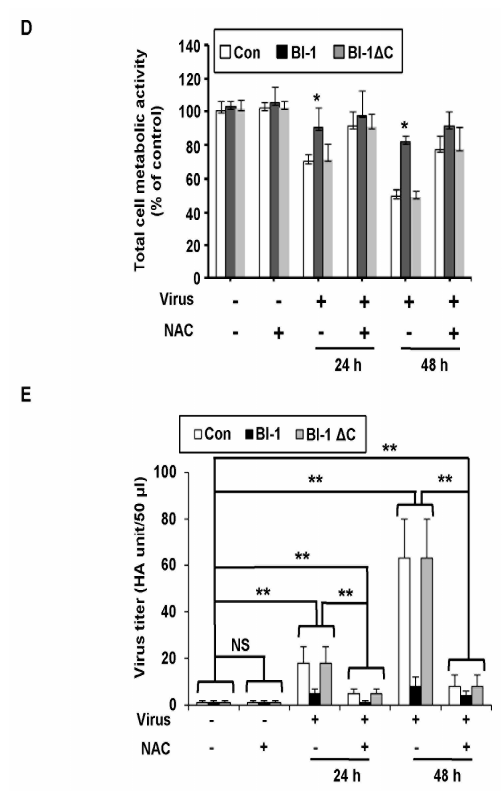
Figure 5. BI-1 may act as an antiviral protein through the suppression of ROS production and ROS-independent regulation of HO-1 expression. ( A ) Control mock MDCK, BI-1 -overexpressing MDCK, or BI-1 ∆ C-overexpressing cells were infected with A/PR/8/34 virus at 1000 TCID 50 and treated with NAC as an antioxidant agent. Intracellular ROS levels were measured in control mock MDCK, BI-1 -overexpressing MDCK, and BI-1 ∆ C-overexpressing MDCK cells incubated with Redox Red sensor CC-1. Fluorescence-stained cells were imaged on an inverted fluorescence microscope. (Scale bar- 200 µ m). ( B ) Relative expression of ROS was analyzed thrice by flow cytometer in indicated virus-infected cells with or without NAC treatment (** p < 0.01). ( C ) RT-PCR analysis of virus-infected cells to determine the expression of viral genes such as HA , NA , and NP and the endogenous HO-1 gene in the host cells. ( D ) Cells were infected with A/PR/8/34 virus at 100 TCID 50 and treated with NAC. MTT assay was performed 24 h and 48 h after virus infection, and the relative expression compared to the control infection results are shown as the mean ± SEM from three individual experiments (* p < 0.05). ( E ) Hemagglutination assay of the virus-infected cells with and without NAC treatment. HA titers were calculated triplicates as hemagglutination units/50 µ L (HAU/50 µ L) using 1% chicken RBCs (** p < 0.01). (Abbreviations: hemagglutinin ( HA ), neuraminidase ( NA ), nucleoprotein ( NP ), and heme oxygenase-1 ( HO-1 )).